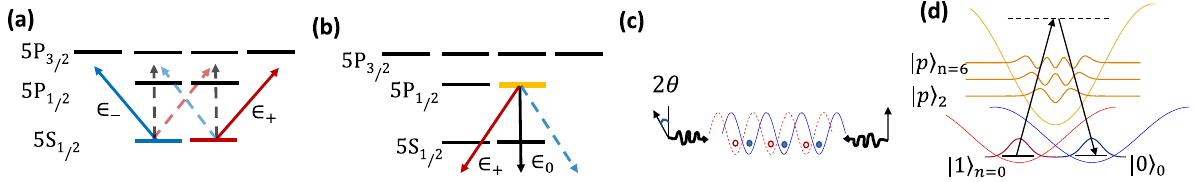
Fig. 8 Qubit rotation in the spin-dependent lattice. a In Rb (Cs), tuning the trapping laser between 5 P 3/2 (6 P 3/2 ) and 5 P 1/2 (6 P 1/2 ), the polarizability of qubit states 0 j i and 1 j i are given by left ε − and right ε + circularly polarized lights respectively. b The same fi elds, trap the p j i ¼ j 5 ð 6 Þ P 1 = 2 ; 1 = 2 i electronic state with ε 0 and ε + elements. c The relative polarization of 2 θ between counter-propagating linearly polarized lights could be tuned to trap the intermediate state between the qubit states ( d ). The Raman transition in a dual spin/spatial encoded qubit would be modi fi ed by the Frank-Condon